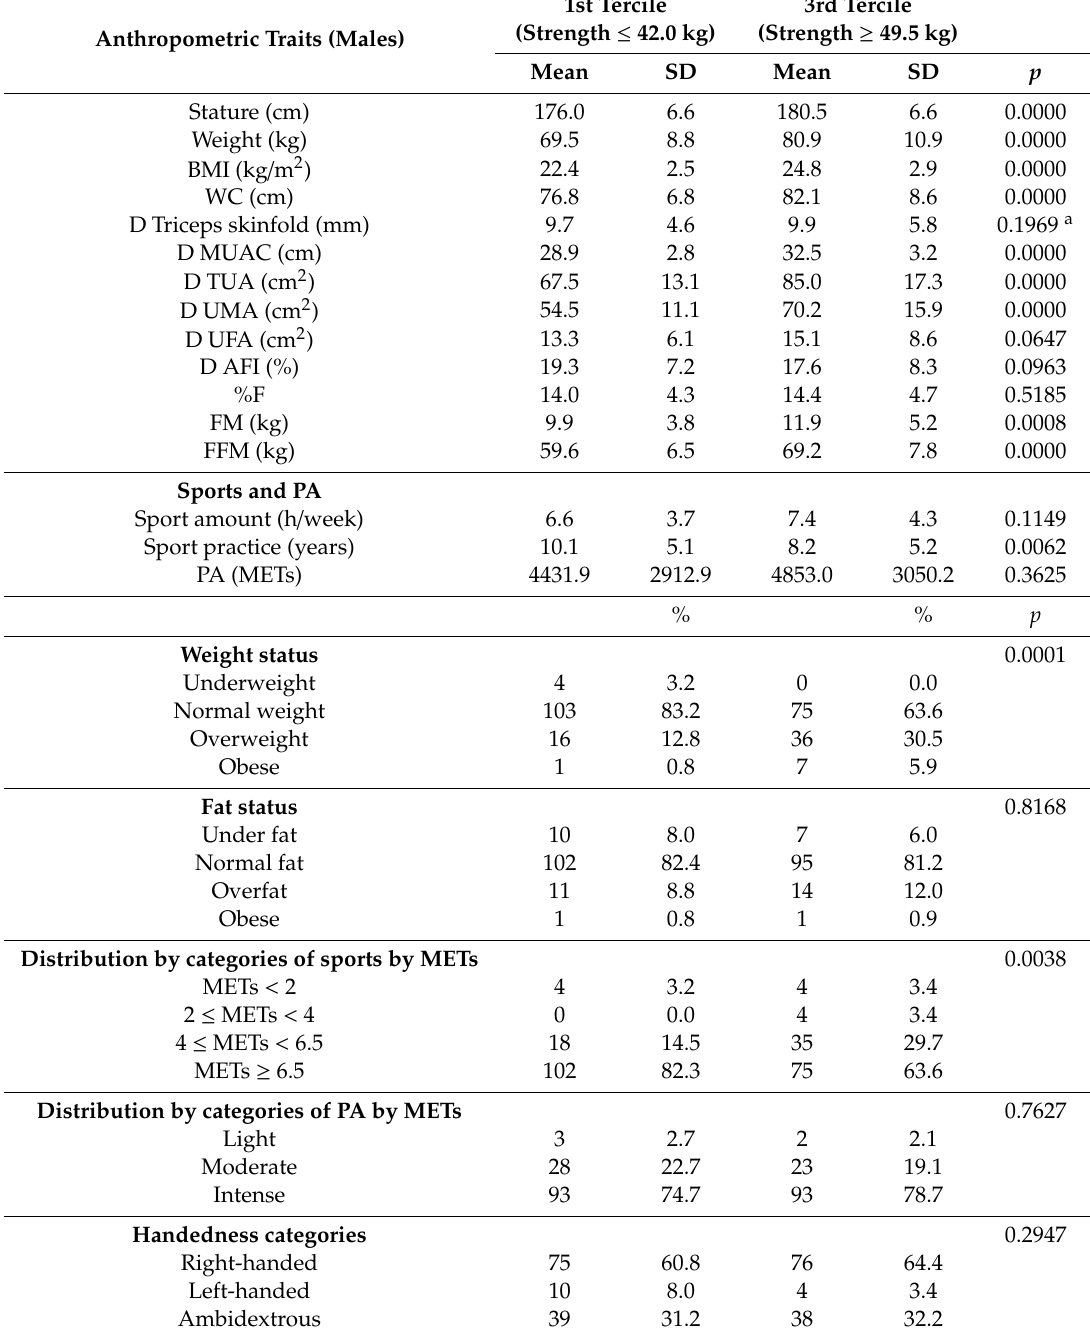
Table 4. Comparison between first and last tercile of dominant handgrip strength in males (D = dominant side).